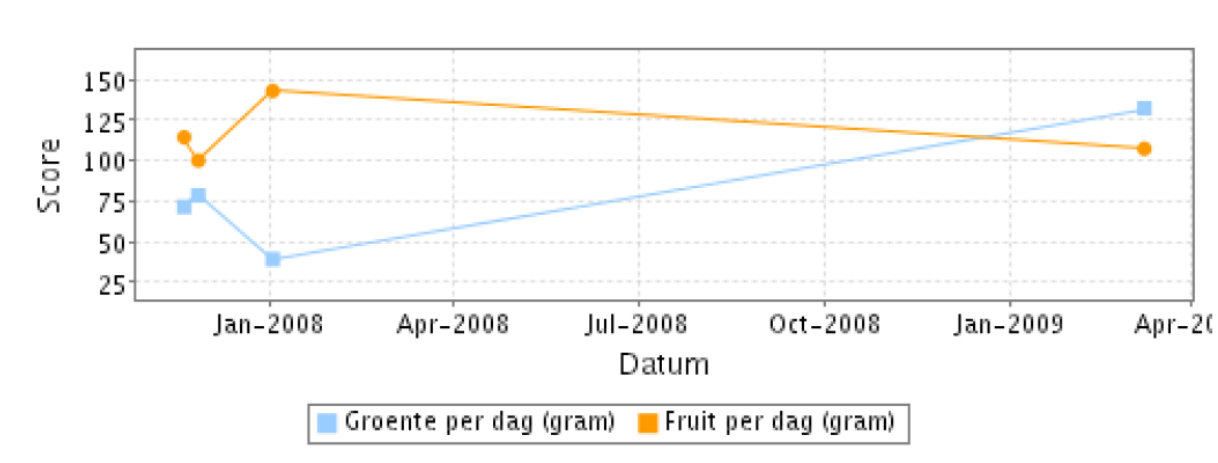
Figure 2. Example of the self-monitor for fruit and vegetable